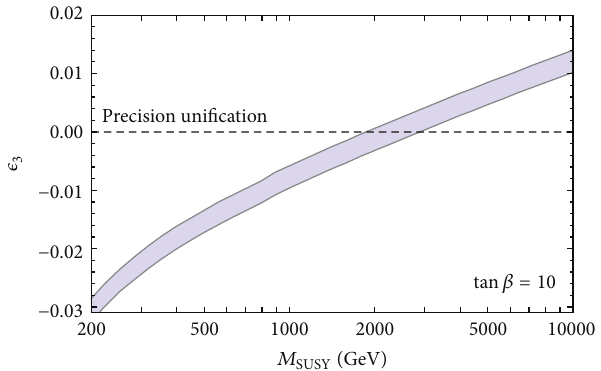
Figure 1: The prediction of grand unification for the effective scale 𝑀 . The width of the band represents the 1 𝜎 experimental error SUSY in 𝛼 𝑠 (𝑀 𝑍 ) .